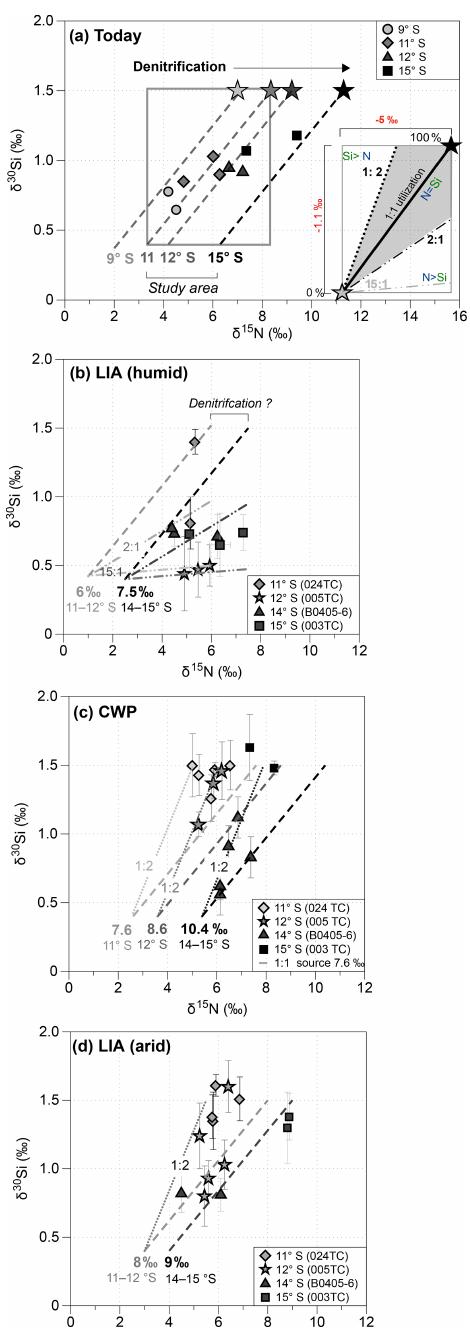
Figure 5. (a) Direct comparison of δ 15 N bulk versus δ 30 Si BSi for modern surface sediments (modified from Ehlert et al., 2015): the dashed lines indicate 1 : 1 utilization of different δ 15 NO − source values (7‰, 7.9‰, 8.35‰ and 11.3‰) between 9 and 15 ◦ S (based on Mollier- 3 Vogel et al., 2012); the rectangle marks the respective range of isotope values that can be expected in sediment samples for nutrient utilization with source values of 1.5‰ ( δ 30 Si ( OH ) 4 ) and 8.35‰ ( δ 15 NO − ). (inset of a ) Schematic overview of nutrient utilization associated with 3 changes in the isotopic compositions of both δ 15 N and δ 30 Si: the black star marks the source signature (or 100% utilization) for δ 15 N and for δ 30 Si, the grey star marks the respective isotopic compositions for 0% utilization, and the dashed black line indicates the 1 : 1 utilization : Si ( OH ) for NO − 4 . Ratios that plot above the utilization lines reflect Si ( OH ) 4 limitation, as indicated by the dotted dark grey and dotted 3 light grey lines, representing ratios of 1 : 2, whereas data points below record stronger NO − limitation, as indicated by the dashed dark grey 3 and light grey lines representing ratios of 2 : 1 and 15 : 1. The rectangle indicates the total range of possible isotopic values. (b–d) Downcore comparison of δ 15 N bulk and δ 30 Si BSi for cores 024TC (diamonds), 005TC (grey stars), 003TC (grey squares) and BO405-6 (grey triangles; Ehlert et al., 2015) for the CWP and the LIA. For the LIA the sample values are separated into arid (d) and humid periods (b)